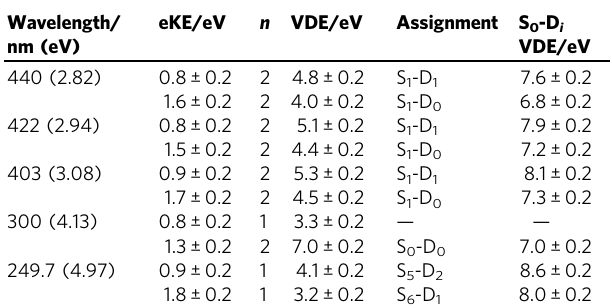
Fig. 2 Photoelectron spectra of aqueous p -HBDI − and electronic con fi gurations and molecular orbitals of aqueous p -HBDI − . a MP detachment photoelectron spectra (grey lines) of 20 μ M aqueous solution of p -HBDI − recorded following photoexcitation at 440 nm, 422 nm, 403 nm, 300 nm, and 249.7 nm, plotted as a function of eKE. Fitted Gaussians represent S 1 -D 0 (dark green), S 1 -D 1 (light green), S 0 -D 0 (grey, see text), S 4 ! e (cid:2) ð (dashed line, see text), S 6 -D 1 (pink), and S 5 -D 2 (purple) detachment processes. b Left: electronic con fi gurations and molecular orbitals of the fi rst few electronic states of p -HBDI − and the corresponding neutral radical in aqueous solution. Arrows highlight the detachment processes contributing to the photoelectron spectra presented. Right: natural π - and n-type orbitals obtained using CASSCF(16,14) with the pure π and mixed n/ π active spaces, respectively. In the depiction of molecular geometries, carbon atoms are shown in black, oxygen atoms in red, nitrogen atoms in blue and hydrogen atoms in white. Table 1 Experimental vertical detachment energies (VDEs) of p -HBDI − in aqueous solution. Measured centres of Gaussians fi tted to the photoelectron spectra in Fig. 2a, eKE, associated values of VDE = nh ν − eKE, where n is the number of photons required to detach the electron from the assigned singlet state, assignments and corresponding S 0 - D i VDEs (see Discussion). The error bars associated with the measured eKEs re fl ect experimental uncertainties (Supplementary